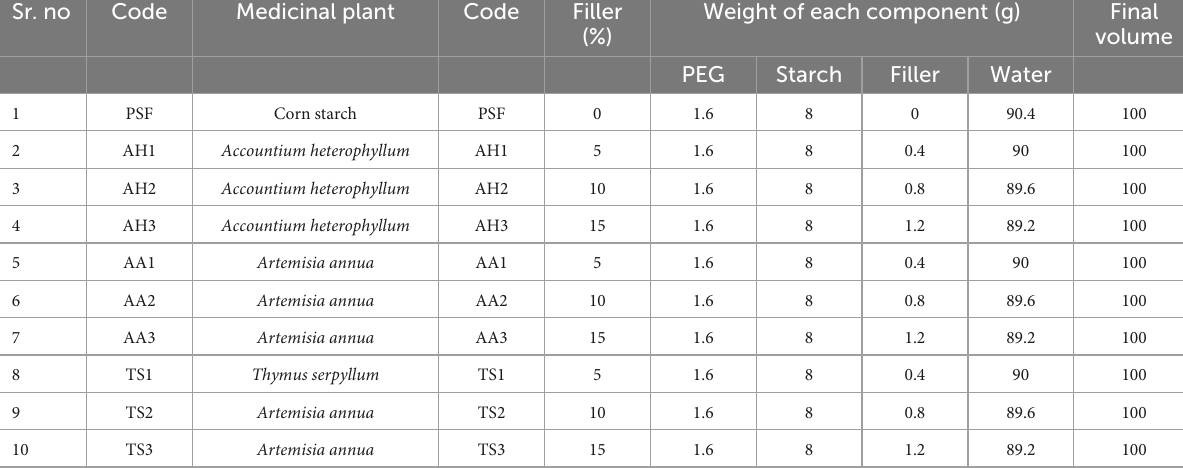
TABLE 1 Sample codes of films reinforced with different medicinal plants. Sr.